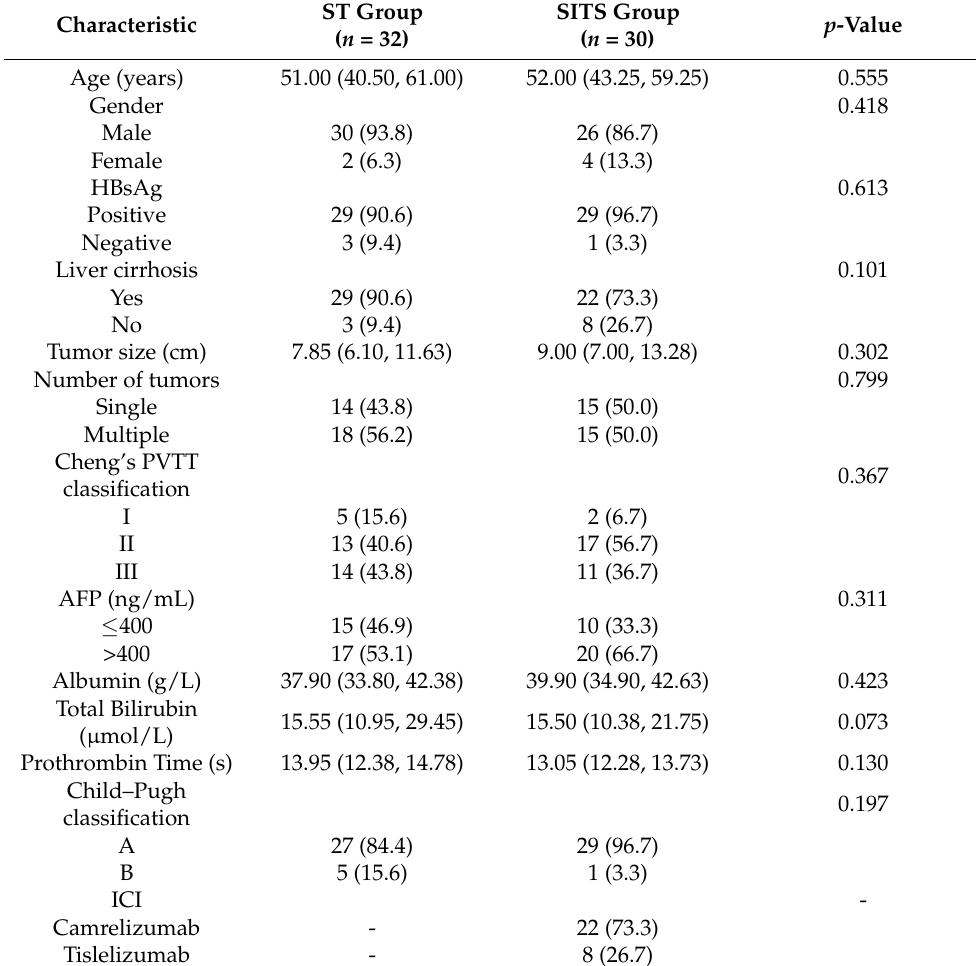
Table 1. Clinical and pathological